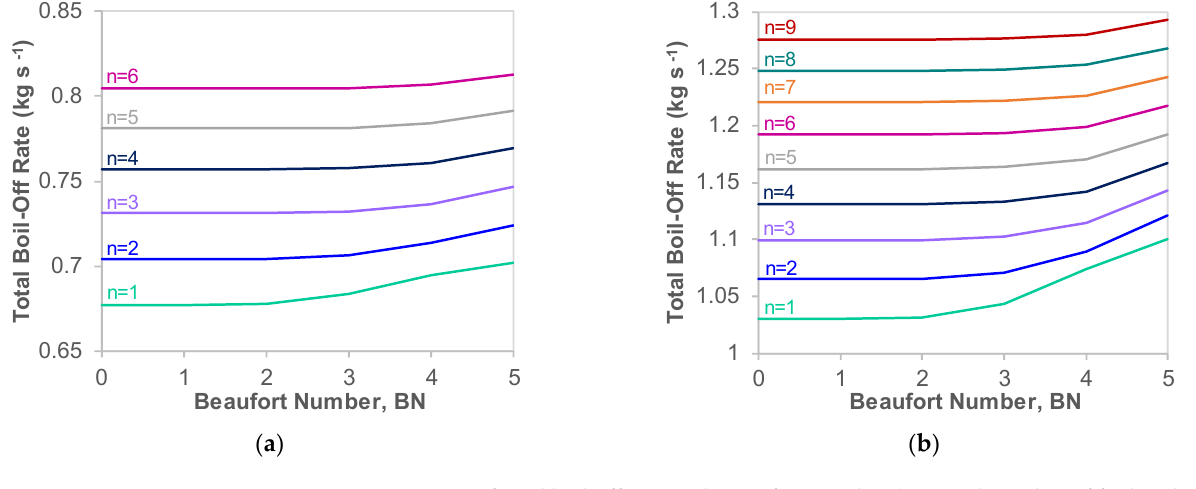
Figure A1. Variation of total boil-off rate with Beaufort number (BN) and number of fuel tanks ( n ) at a ship velocity ( v ship ) of 10 kn ( a ) An LNG ship; ( b ) An LH2 ship with the same insulation thickness as the LNG carrier, without reliquefaction.